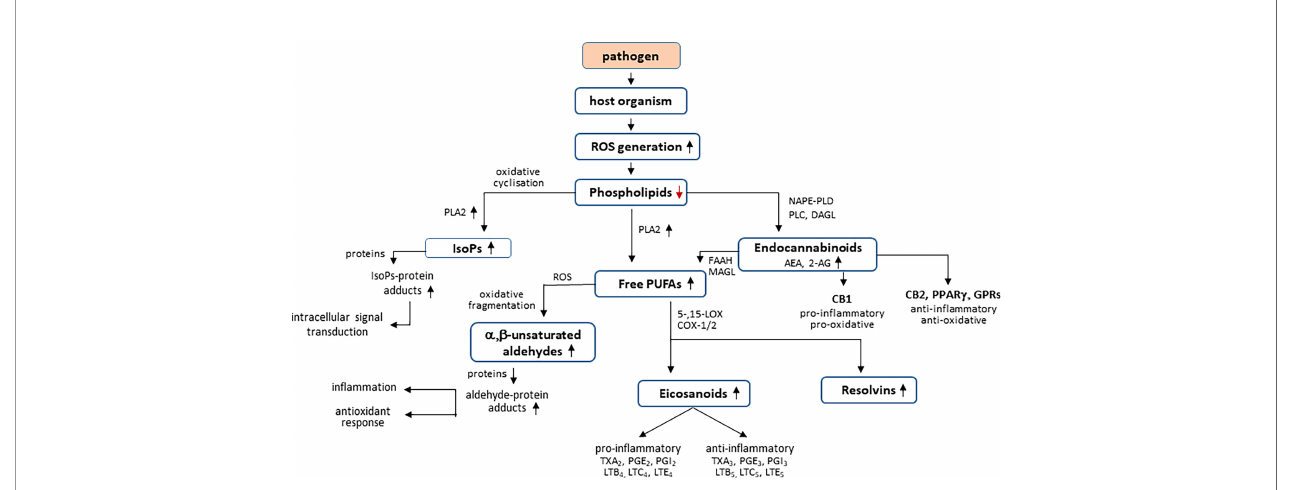
FIGURE 2 | Effect of pathogens on phospholipid metabolism in host